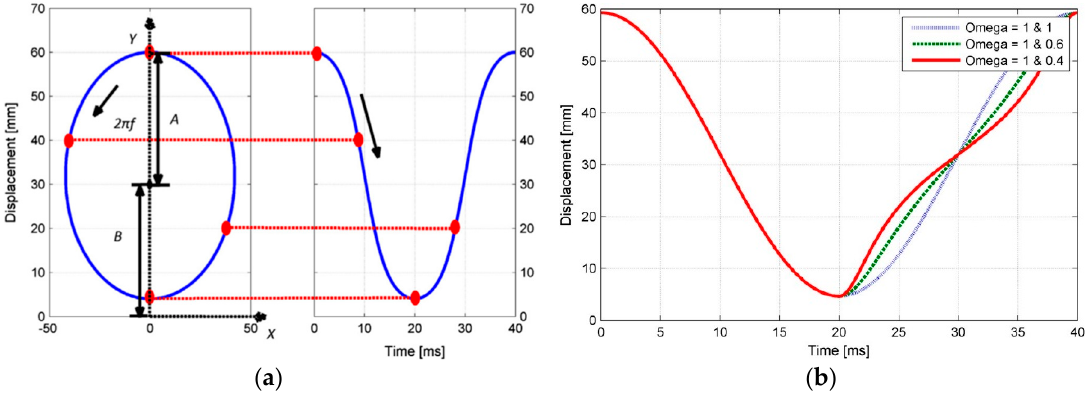
Figure 30. The basic principle diagram of reference trajectory. ( a ) Description of FPLG piston motions, ( b ) Various piston trajectories with different omega.